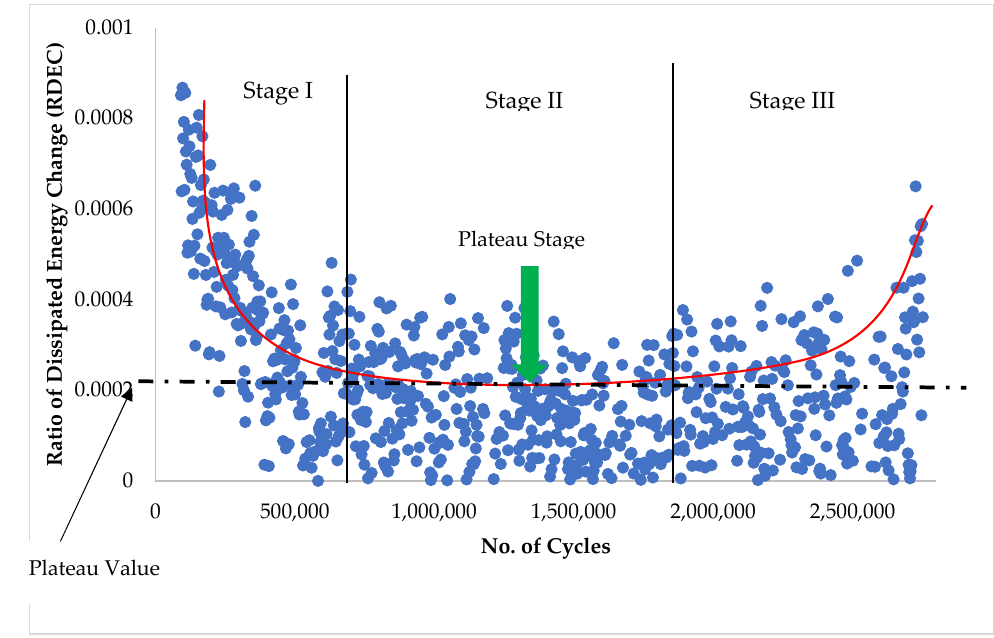
Figure 4. Plastomers RDEC plot using the approach developed by Carpenter et al. [94].